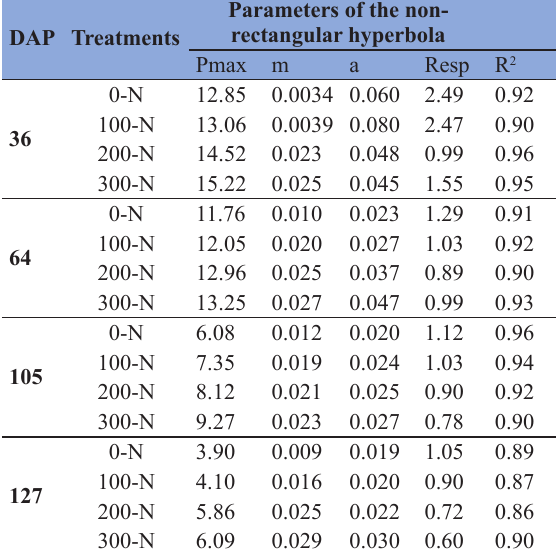
Table 1 . Parameters of the non-rectangular hyperbola during days after planting (DAP) in the different treatments of nitrogen fertilization: 0, 100, 200 and 300 kg N ha -1 . The coefficient of determination (R 2 ) is